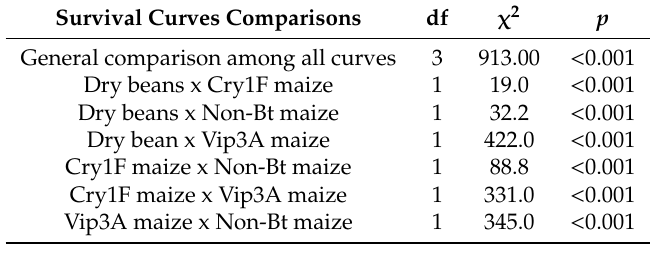
Figure 2. Survival curves of immature S. albicosta (larvae, prepupae, and pupae) from larvae reared on dry beans, non- Bt , Cry 1F and Vip3A maize under controlled conditions. Note that only the Vip3A maize curve reached zero, and the others stopped at the percentage of adults that emerged (Log Rank test, χ 2 = 913.00, df = 3, p < 0.001). Table 1. Chi-square and p -values from Log Rank test for comparison between survival curves.